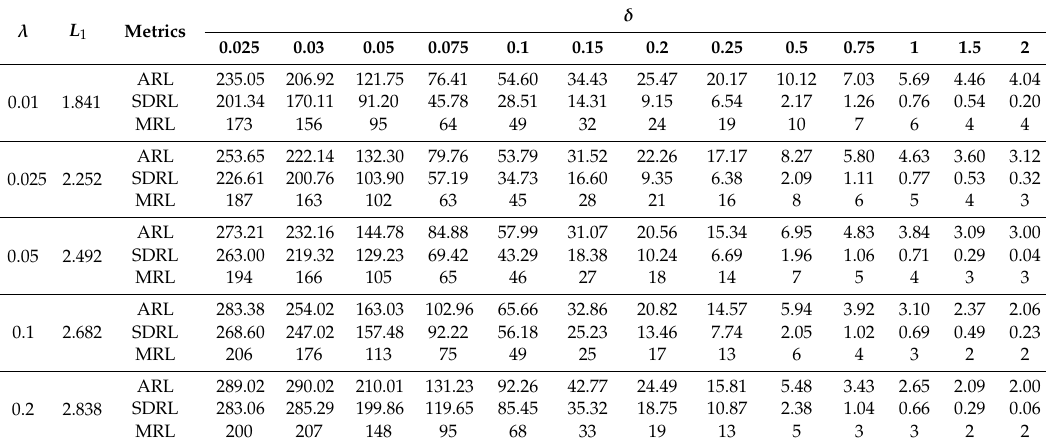
Table 5. Out-of-control (OOC) RL profiles of the proposed chart under di ff erent values of λ